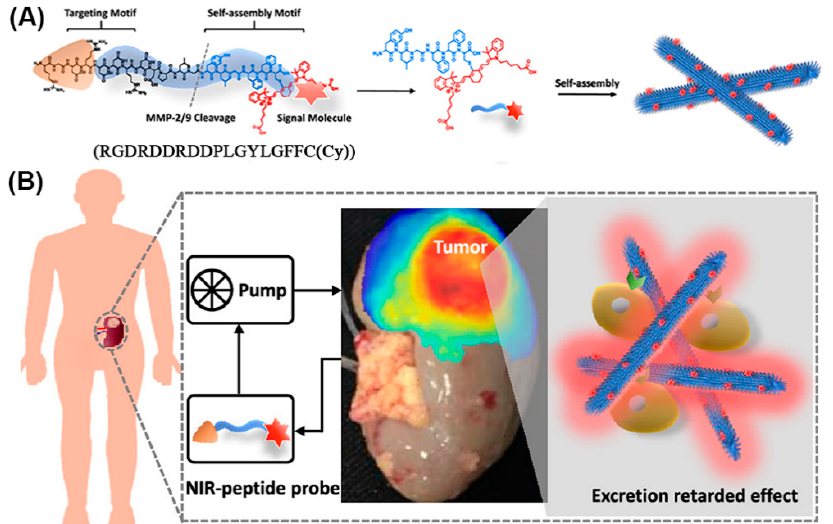
Figure 18. ( A ) Modular molecular design of the NIR peptide and the self-assembly of the peptide after cleavage by MMP-2/9. ( B ) NIR fluorescence image of tumor-bearing human kidney tissue after ex vivo perfusion for 2 h. Adapted and modified from [188], with permission. Copyright: 2020 American Chemical Society.